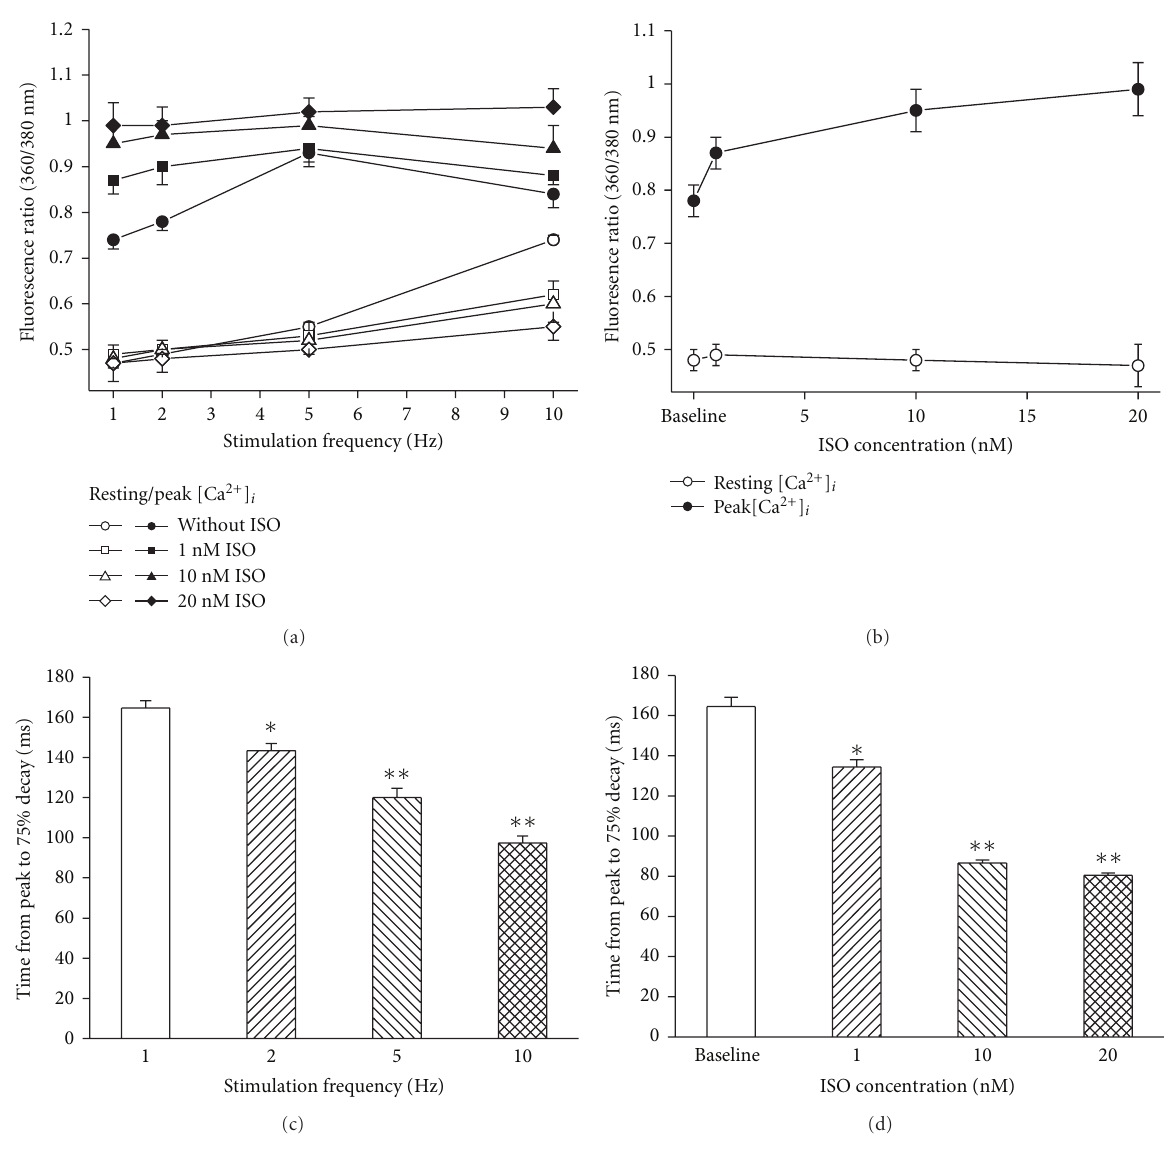
Figure 5: Resting and peak calcium concentrations in cardiomyocytes and time from peak to 75% decay (TD 75 ) under di ff erent frequencies of stimulations with and without ISO treatment. Data are mean ± SEM, n = at least 30 myocytes from six hearts for each concentration in each group. At least 5 myocytes were from each heart. ∗ P < 0 . 05 or ∗∗ P < 0 . 01 versus baseline.